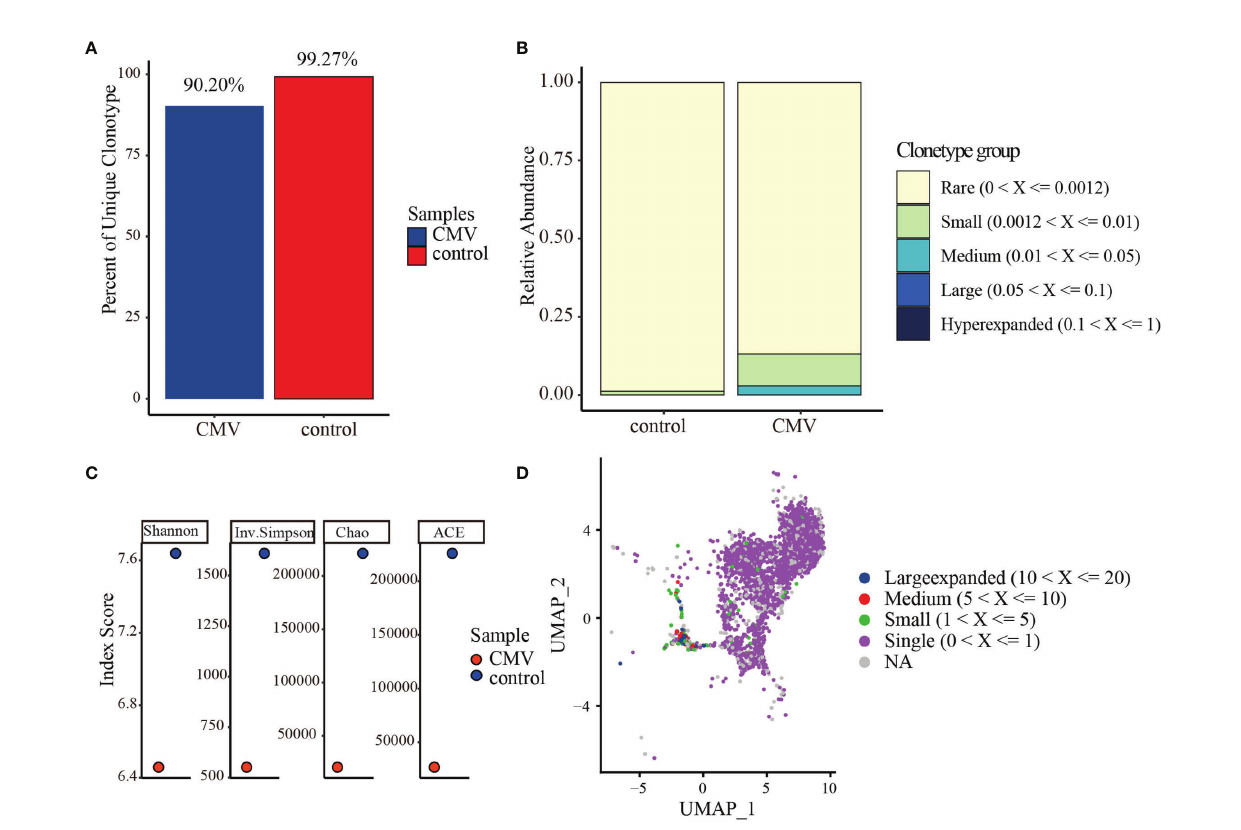
FIGURE 4 | TCR repertoire analysis of CMV and control CD4+ T cells. (A) Percentages of unique (i.e., unexpanded) clonotypes of CMV and control CD4+ T cells. (B) Relative TCR repertoire abundance of CMV and control CD4+ T cells. (C) Diversity measures based on clonotypes by sample type using Shannon, Inverse Simpson, Chao, and abundance-based coverage estimator (ACE) indices. (D) Clonotype distributions of CD4+ T cells. Cloning frequencies ≤ 20 and > 10, ≤ 10 and >5, ≤ 5 and >1 were de fi ned as large expanded, medium expanded, and small expanded,